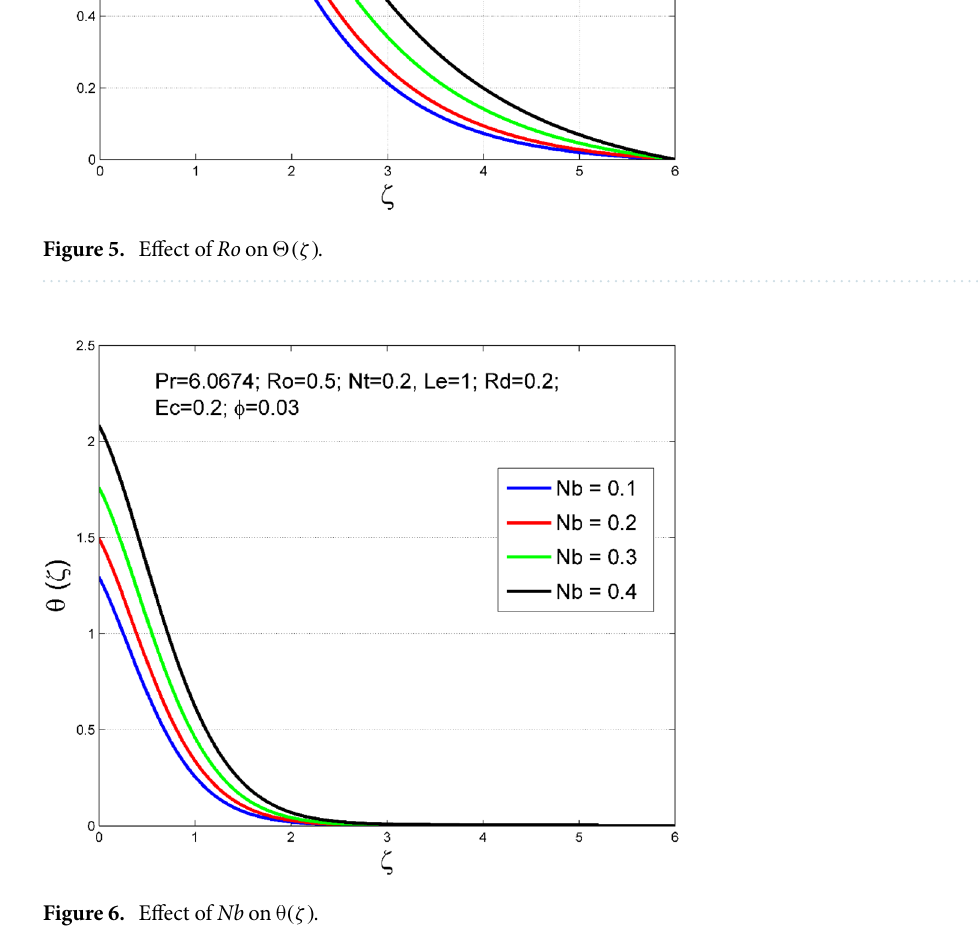
Figure 6. Effect of Nb on θ (ζ)